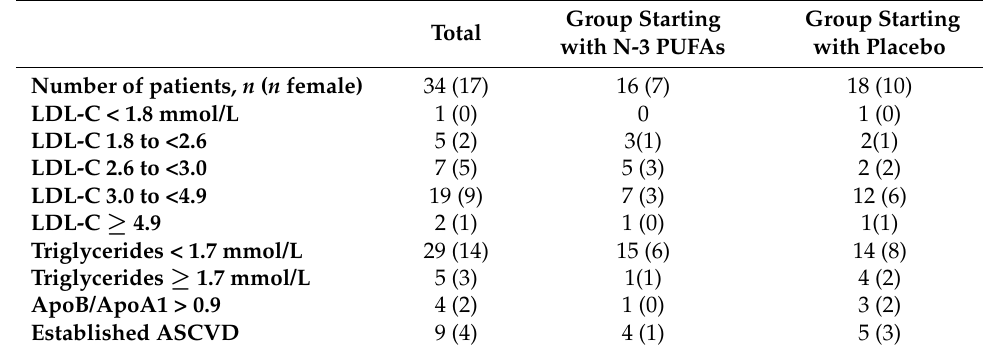
Table 2. Baseline characteristics and intervals of LDL-C and